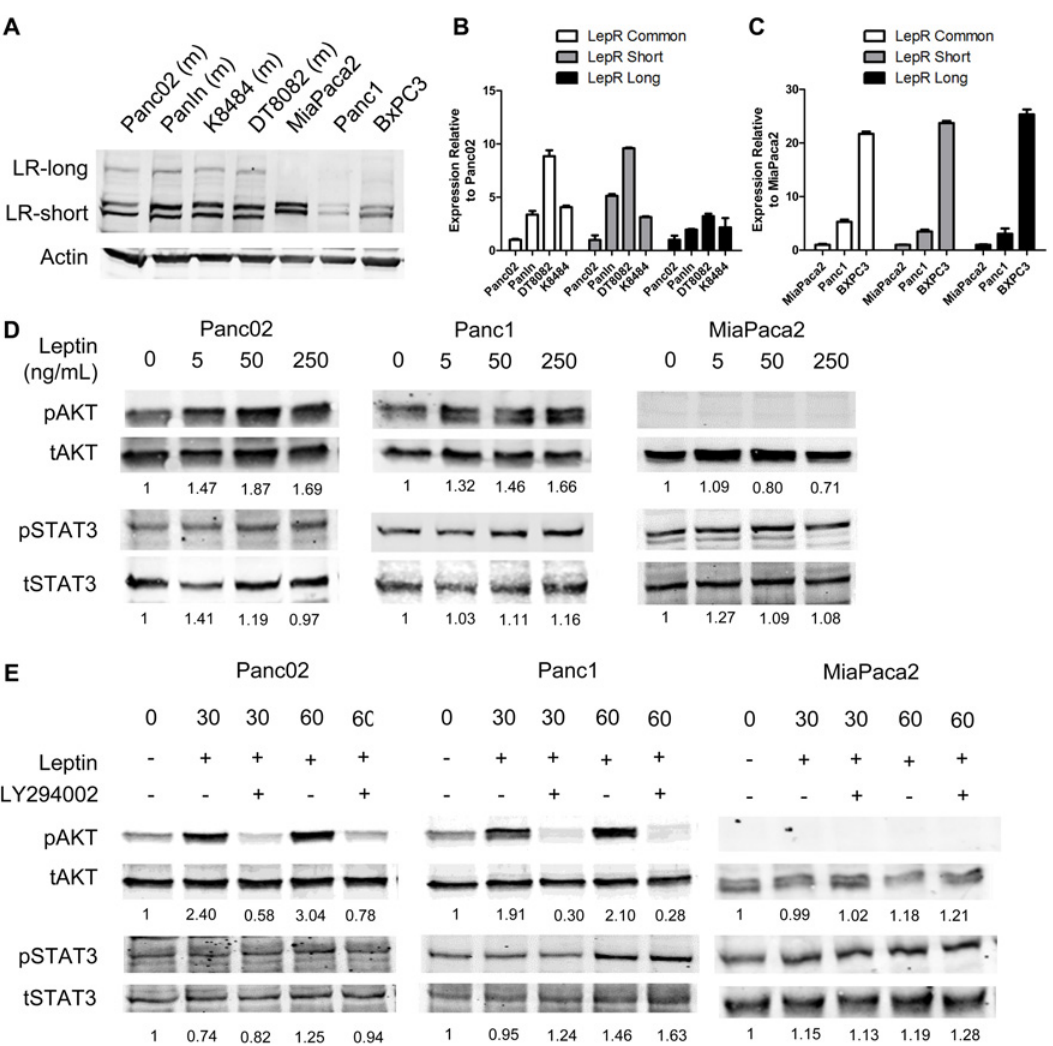
Fig 3. Pancreatic cancer cell lines express functional leptin receptors. Western and real-time qPCR analysis verified leptin receptor expression for the long and short forms of the leptin receptor in murine and human pancreatic cell lines (A,B,C). Western anlayis demonstrated stimulation of pancreatic cancer cell lines with leptin lead to the phosphorylation of AKT in the Panc02 and Panc1 cell lines, and to the phosphorylation of STAT3 (D). Addition of the PI3K/ AKT inhibitor LY294002 was able to block leptin induced phosphorylation of pAKT but did not affect leptin induced pSTAT3 activation in the Panc1 cell line. Densitometric analysis was used to quantify the amount of pSTAT3 and pAKT relative to total levels for each protein and then normalized to zero